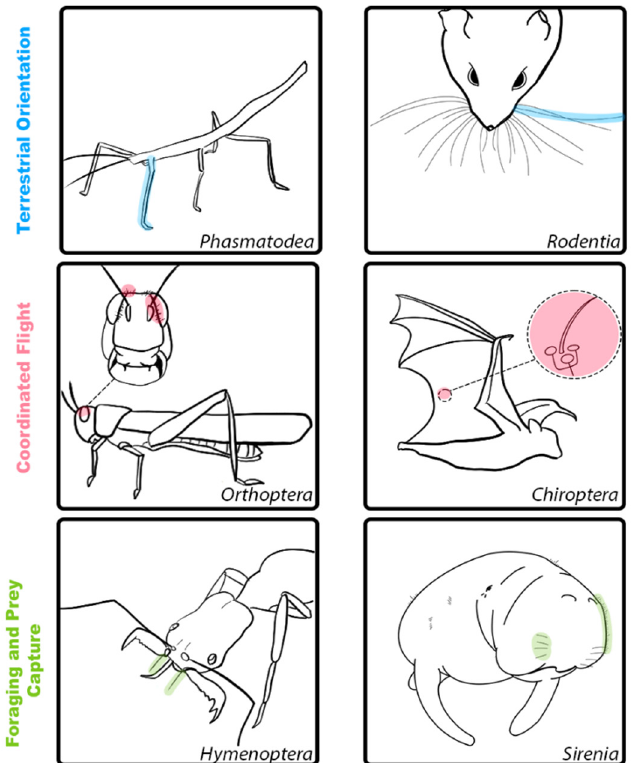
Figure 1. Illustrations of hair and hair-like structures with shared functional properties for select invertebrate and vertebrate species. Top row (blue): Examples of hair and hair-like structures for terrestrial locomotion in Phasmatodea ( left ) and Rodentia ( right ). These structures are involved in orientation and self-guided motion to support coordinated movement. Middle row (red): Examples of hair and hair-like structures for coordinated flight in Orthoptera ( left ) and Chiroptera ( right ). These structures detect airflow and support flight control. Bottom row (green): Examples of hair and hair-like structures for foraging and prey capture in Hymenoptera ( left ) and Sirenia ( right ). These structures are adapted to allow for species-specific foraging behaviors.